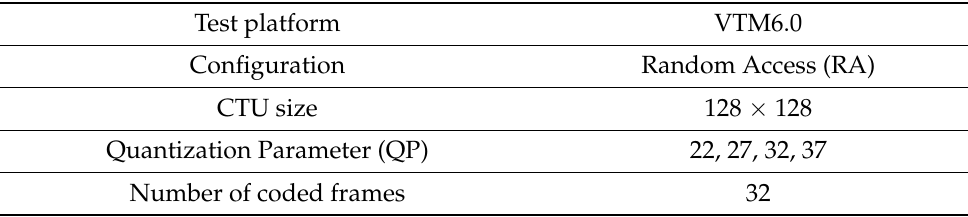
Table 1. Test conditions.